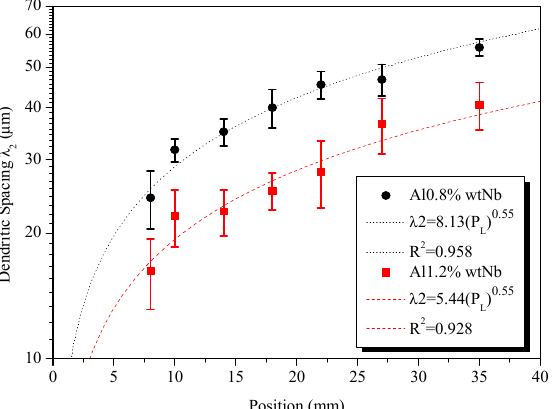
Figure 9. Experimental equations of the secondary dendritic spacing as a function of the metal/mold interface, for alloys Al–0.8%wt Nb and Al–1.2%wt Nb.